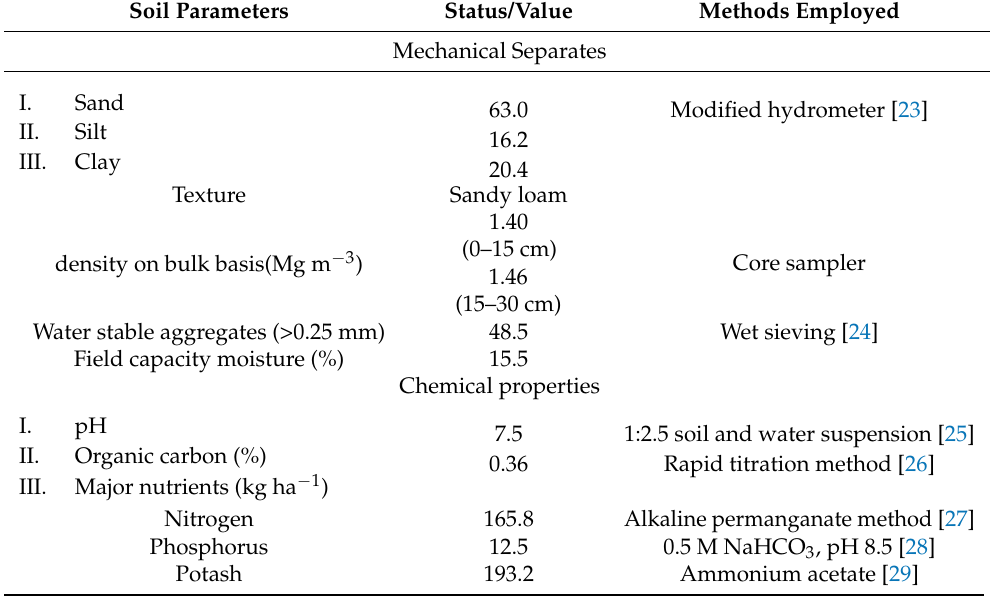
Table 1. Inherent soil properties of the experimental